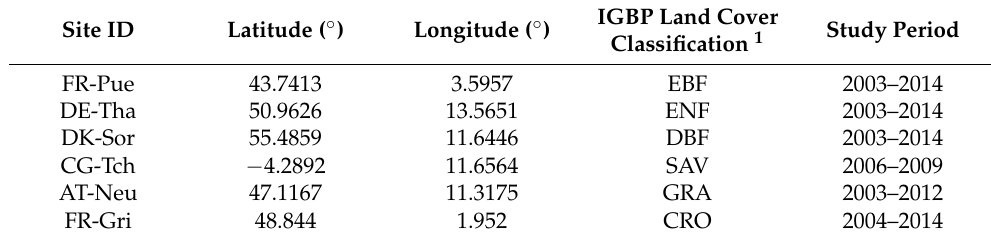
Table 1. FLUXNET site information used in this